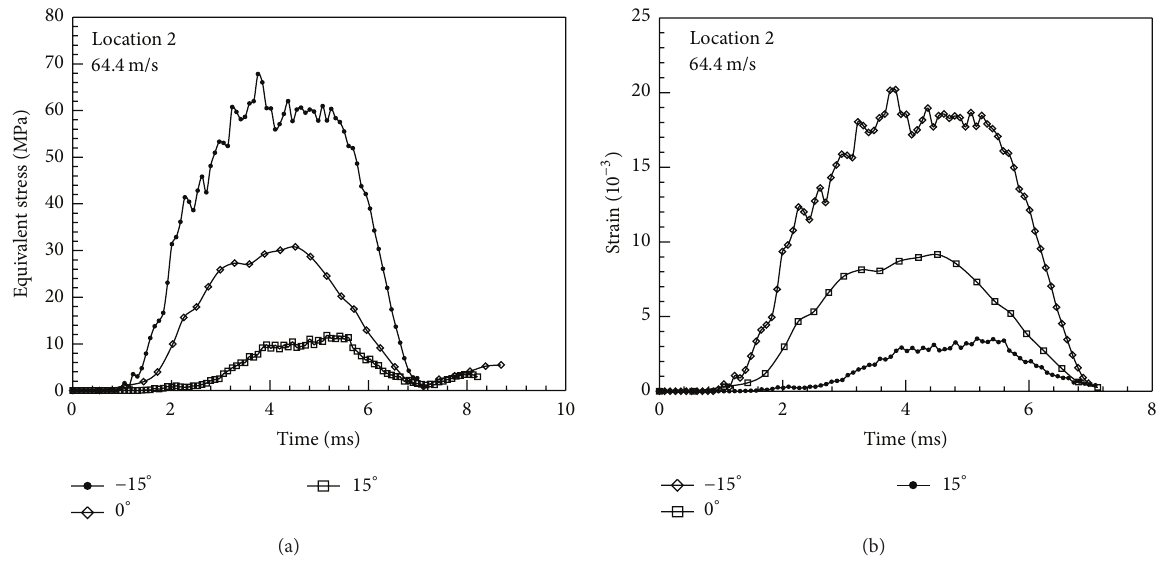
Figure 19: (a) Equivalent stress and (b) strain history during different angles of impact.